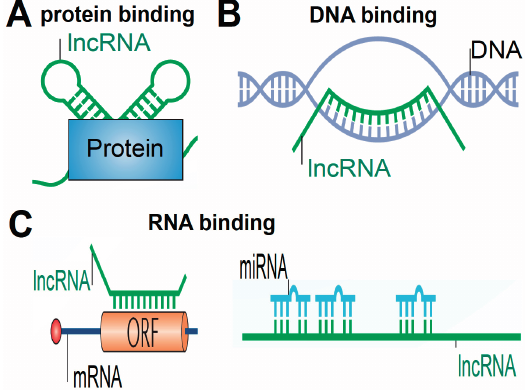
Figure 2. Schematic diagram of lncRNA mechanisms of action. LncRNAs function to regulate gene expression by diverse mechanisms. ( A ) LncRNAs act as molecular guides and scaffolds to interact with protein complexes. LncRNAs also act as molecular decoys for proteins including transcription factors; ( B ) lncRNAs modulate the epigenetics through guiding chromatin-modifying complexes to target genomic DNA loci; ( C ) lncRNAs act as endogenous sponges for other RNAs such as mRNAs and miRNAs. ORF: open reading